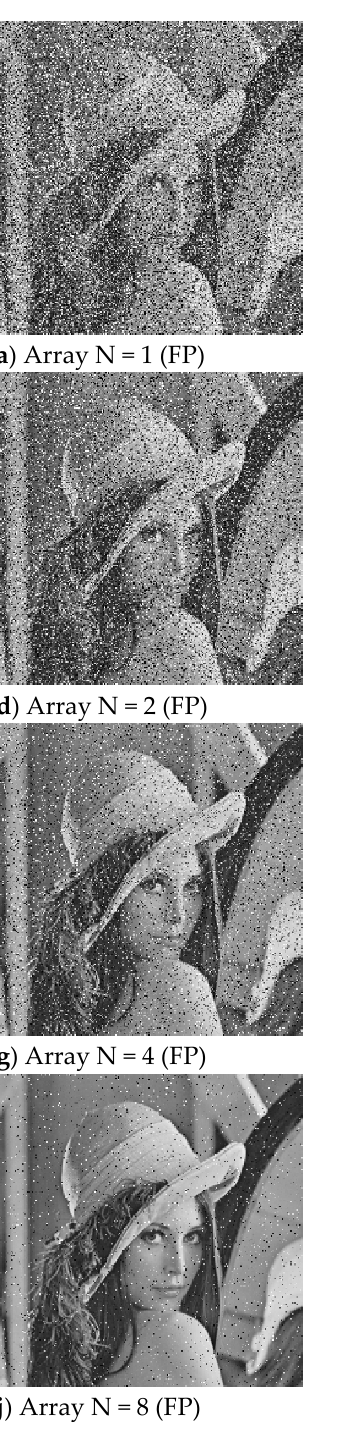
Figure 5. Comparison of denoising effect of Lena image.